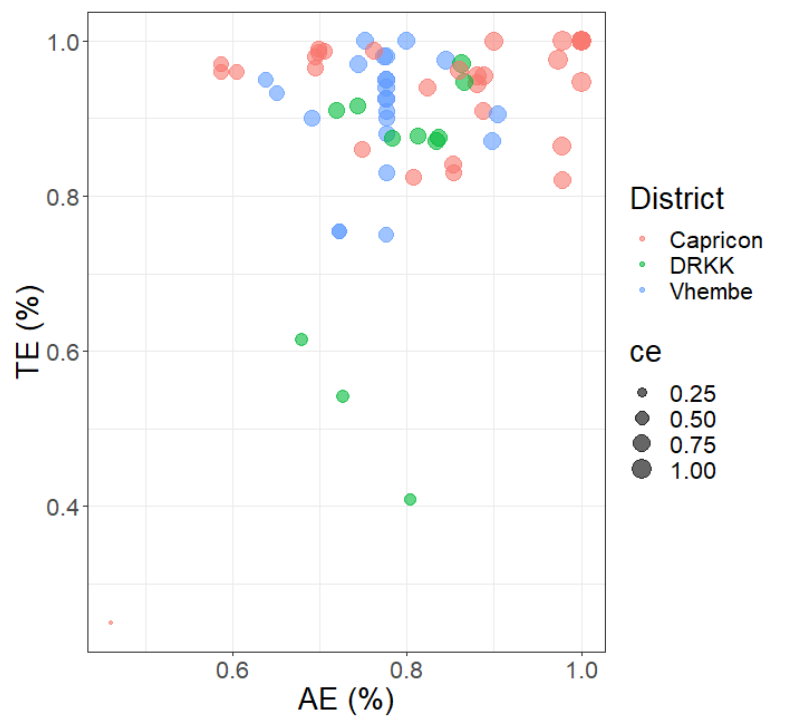
Figure 4. Evaluation of each type of efficiency by